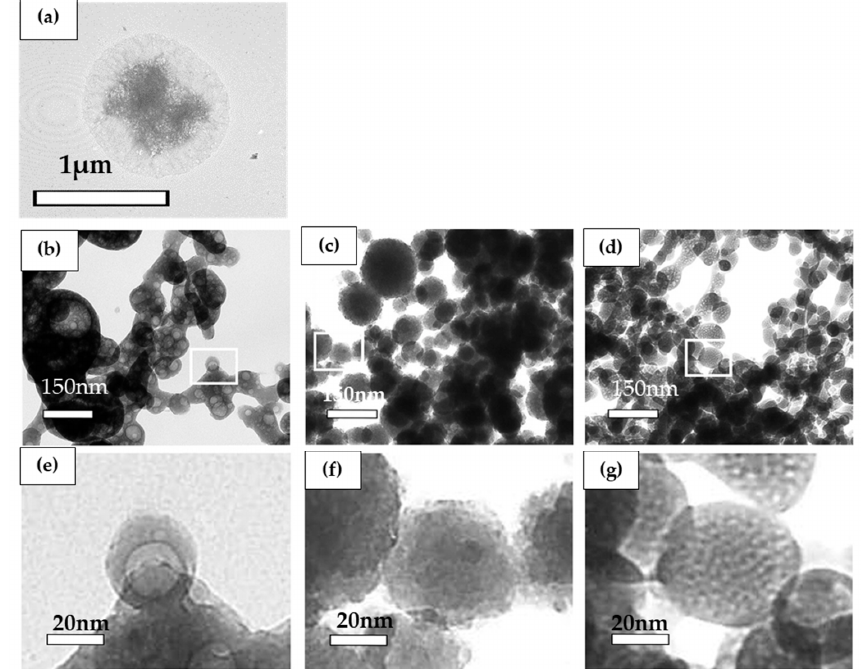
Figure 4. Observation of calcium phosphate precipitation by transmission electron microscopy. Calcium and phosphate concentrations were 12.02 mM and 6.70 mM. The concentrations of